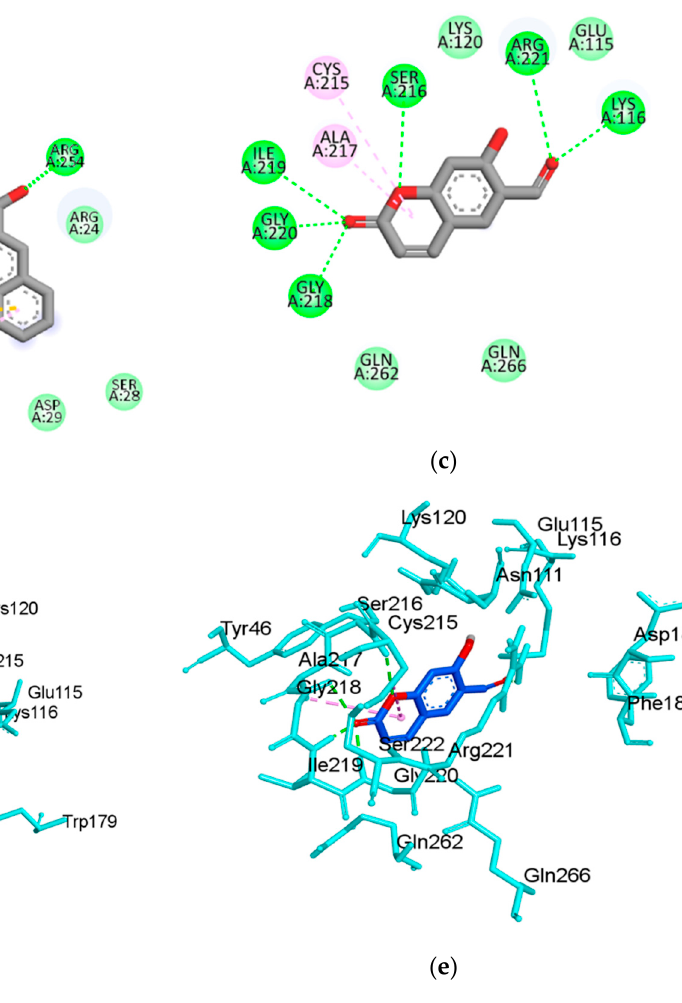
Figure 2. Molecular docking model for protein tyrosine phosphatase 1B (PTP1B) inhibition by 6-FU. ( a ) Overlapping of the docked 6-FU (red) and compound 23 (yellow) within the active site of PTP1B (PDB: 1NNY). 2D interactions of compound 23 ( b ) and 6-FU ( c ) inside the active pocket of PTP1B. Molecular docking model for PTP1B inhibition by 6-FU and diagrams of 3D ligand interactions and major binding interactions of inhibitors with the 1NNY active site: compound 23 ( d ), and 6-FU ( e ). The interactions are represented in green (conventional hydrogen bonding), pink ( π -alkyl interac- tions), gold accent ( π -sulfur), purple ( π -sigma), dark pink ( π - π T shaped), and light green ( π -donor). Table 2. Binding energies and binding interactions of 6-FU, cognate ligands, and positive controls in protein tyrosine phosphatase 1B (PTP1B), α -glucosidase, human recombinant aldose reductase (HRAR), and human serum albumin (HSA) using the Autodock vina docking program and visual- ization by Discovery Studio Visualizer .